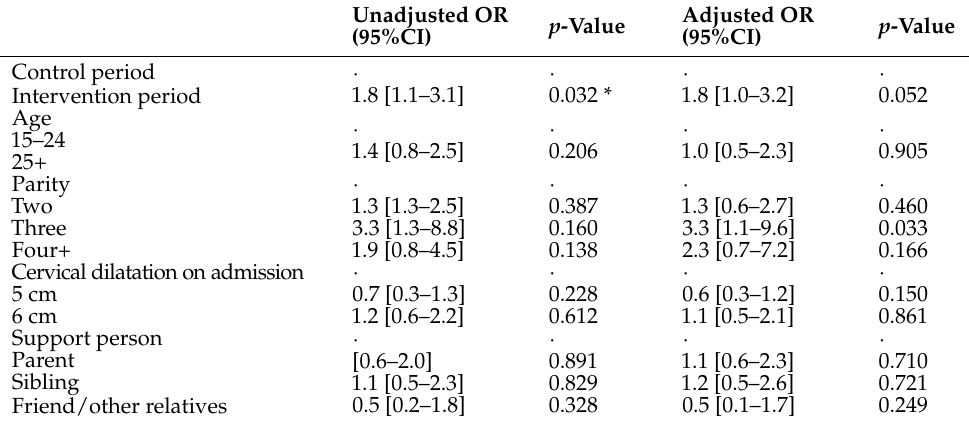
Table 6. Multivariable analysis of coping with